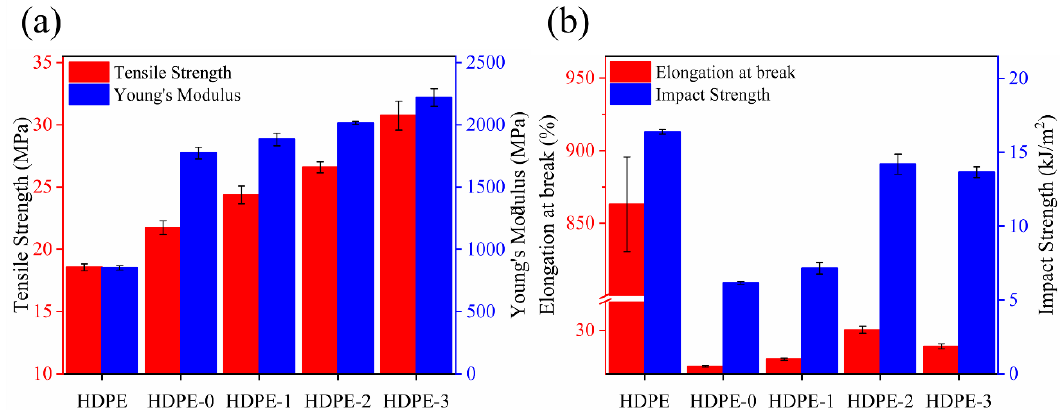
Figure 4. Schematic diagram of mechanical properties of HDPE, HDPE-0 (HDPE/MOSw), HDPE-1 (HDPE/MOSw@SiO 2 ), HDPE-2 (HDPE/MOSw@SiO 2 @KH570), and HDPE-3 (HDPE/MOSw@SiO 2 @PDA) composites. ( a ) Tensile strength and Young’s modulus. ( b ) Elongation at break and impact